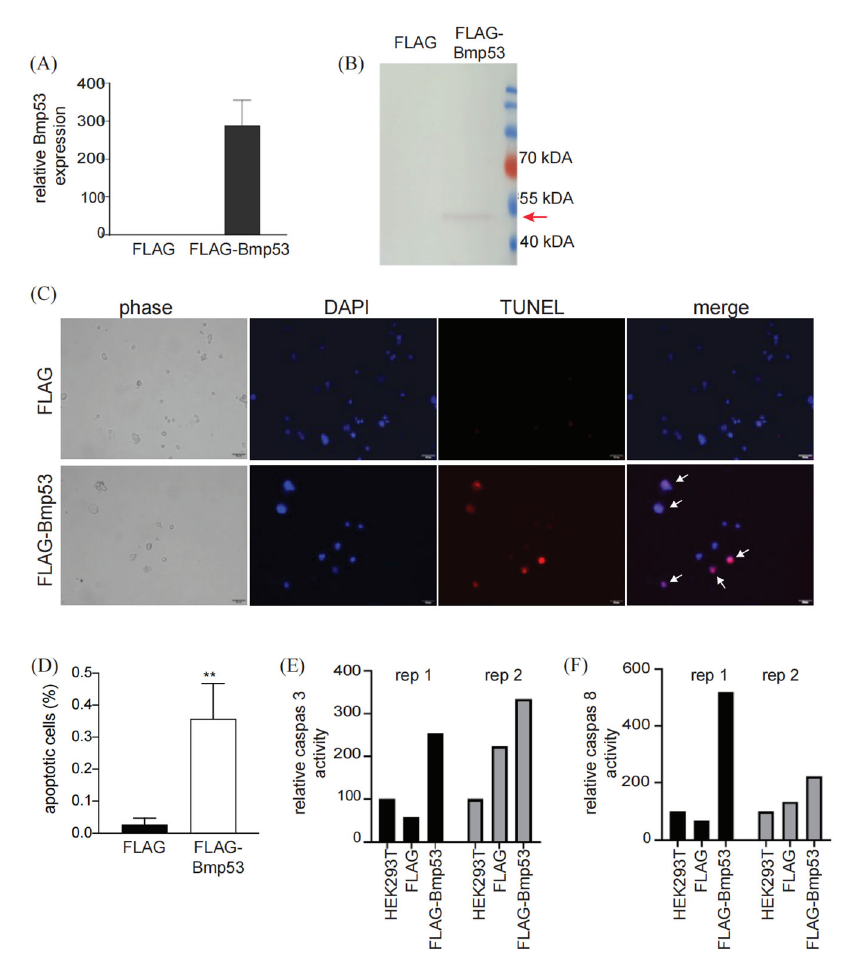
Figure 1. Overexpression of Bmp53 induced apoptosis in mammalian cells. ( A ) Bmp53 transcript levels in pcDNA3.1-3xFLAG-c-Bmp53 transfected and non-transfected HEK293T cells. ( B ) An anti-FLAG immunoblot of pcDNA3.1-3xFLAG-c-Bmp53 transfected and non-transfected HEK293T cells(red arrow: the location of the FLAG-Bmp53 fusion protein). ( C ) HEK293T cells transiently expressing FLAG-Bmp53 were assayed for apoptosis using a TUNEL BrightRed apoptosis detection kit. Red fluorescent signals indicate broken DNA, a hallmark of cellular apoptosis. Nuclei were counter-stained with DAPI (blue fluorescence). Co-localization of DAPI and red fluorescence is indicated by the white arrows. Scale bar = 50 µm. ( D ) The percentage of FLAG- or FLAG-Bmp53-expressing cells that were positive for the apoptotic TUNEL signal. Statistical significance determined via student t-test ( ** p < 0.01) across three transfection replicates. Signals were determined for at least 30 cells in each transfection experiment. ( E ) Overexpression of FLAG-Bmp53 in HEK293T-induced caspase 3 activity. ( F ) Overexpression of FLAG-Bmp53 in HEK293T-induced caspase 8 activity. Caspase activity was determined across duplicated experiments.